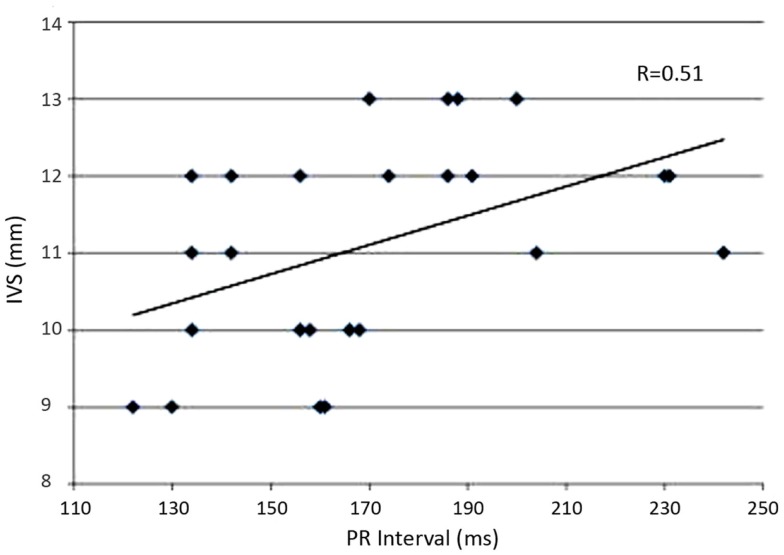
The graph represents the linear regression between interventricular septum (IVS) wall thickness and PR interval duration in patient with primary aldosteronism.